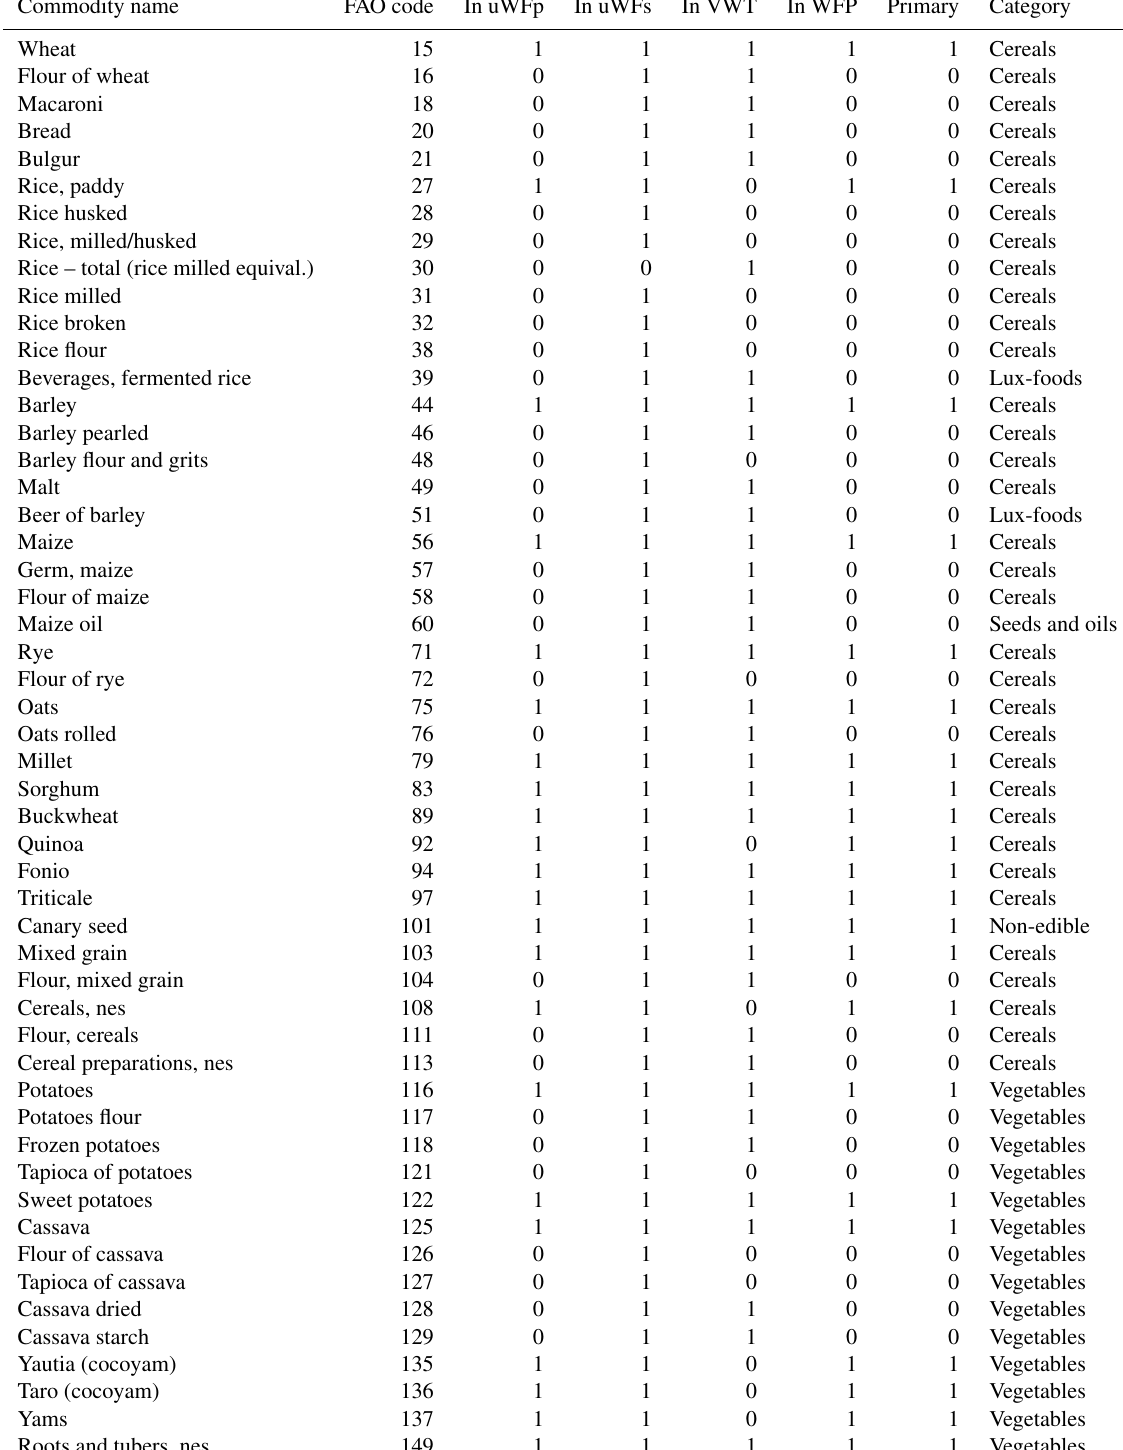
Table A1. List of commodities in the CWASI